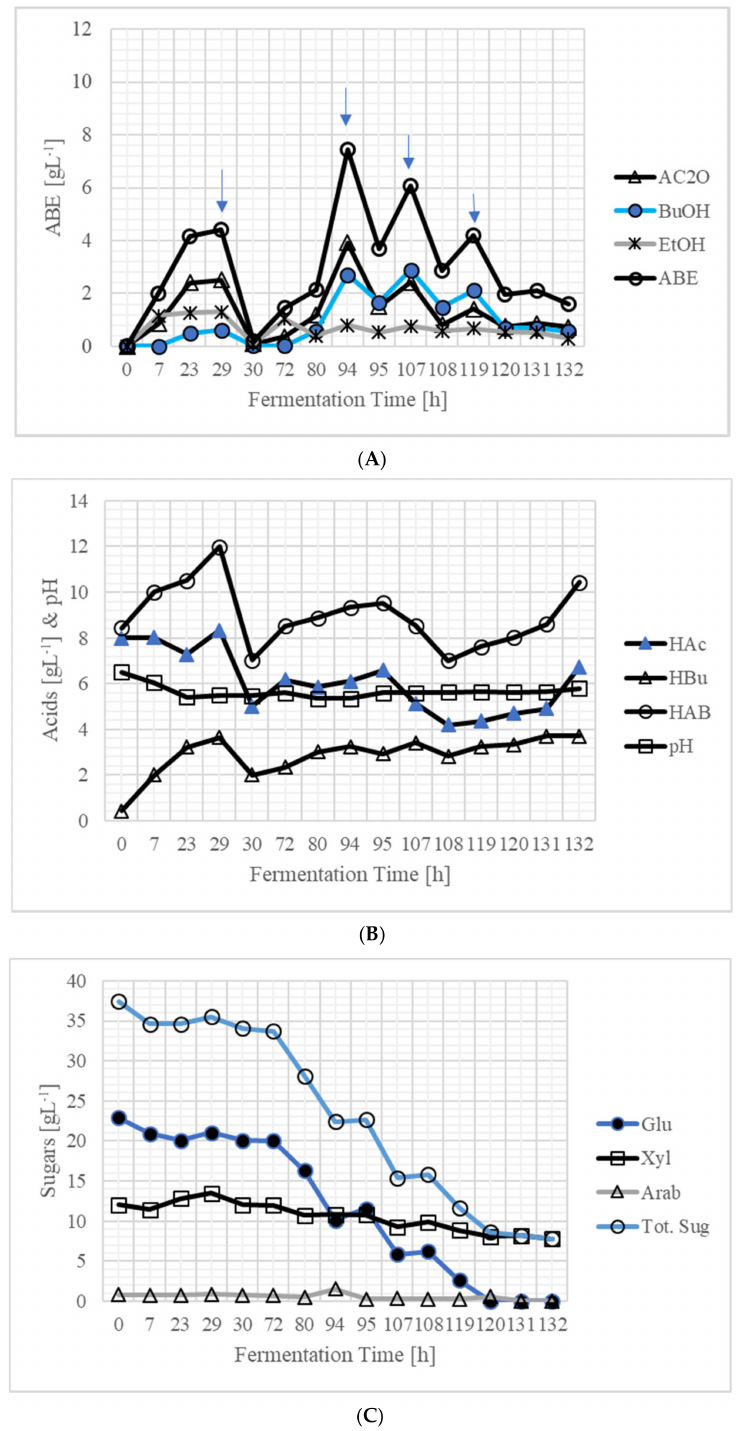
Figure 3. Production of ABE from 160 gL − 1 (16% dry wt. basis) SSB in an integrated process of simultaneous saccharification, fermentation, and recovery: ( A ) ABE (abbreviations as in Table 2)— arrows indicate the points at which a vacuum was applied for 30 min to recover ABE. During 30 min of vacuum, the ABE were recovered, and ABE concentrations below inhibitory levels were reached in the reactor; ( B ) acids; and ( C ) sugars. Throughout the fermentation, vigorous gassing was observed. After recovery at 119 h, 3 mL of yeast extract (YE, from 40 gL − 1 ) solution was added as a nutrient solution. The initial reaction volume (when the reactor was inoculated) was 177 mL, and the final volume, when fermentation ceased at 132 h, was 150